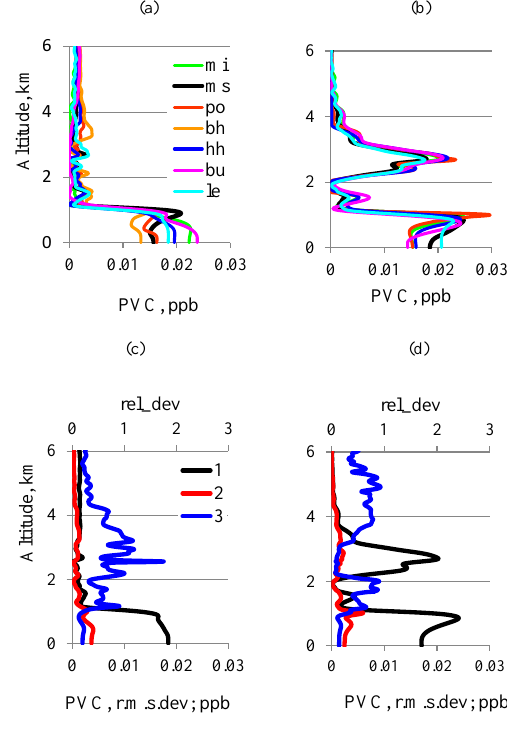
Figure 5. Identical to Fig. 4 except for data from three lidar channels (355, 532 – intensity/parallel polarized component, and 1064nm) and two mode aerosol model were used. Label “le” stands for lidar “PollyXT” of TROPOS, Leipzig: (a, c) – fine, (b, d) – coarse spherical aerosol mode.